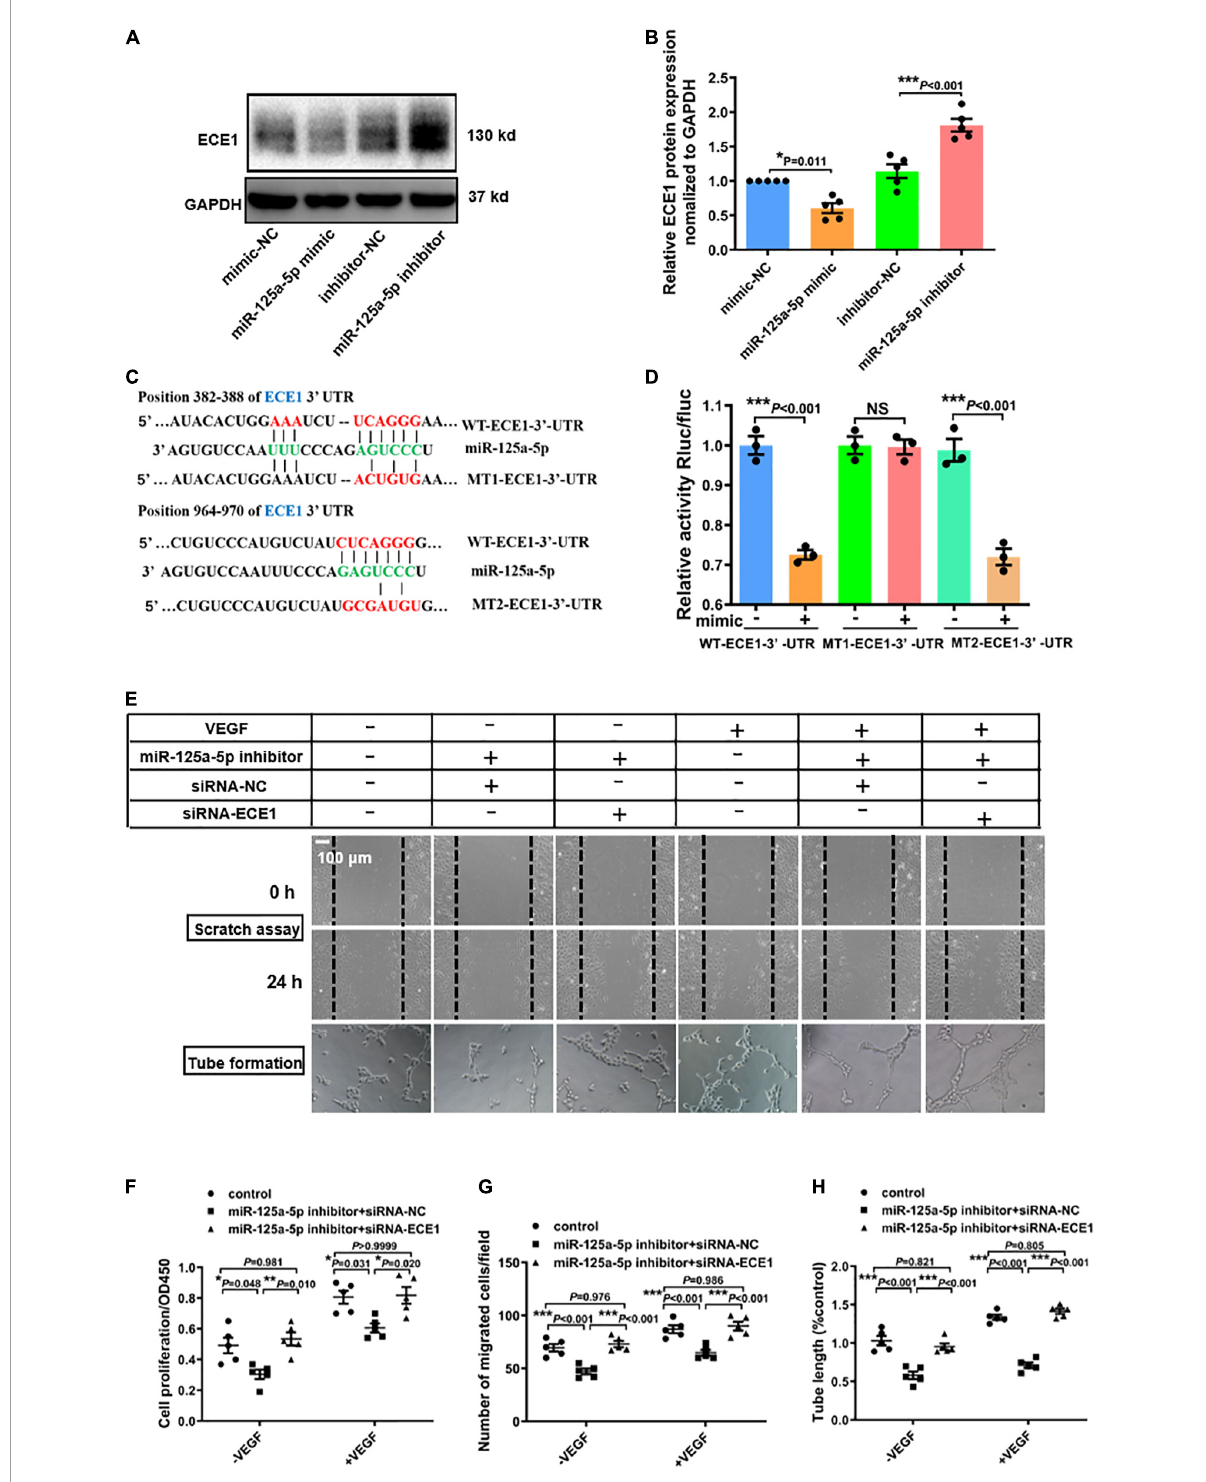
FIGURE5 miR-125a-5p promotes the proliferation, migration and tube formation of HUVECs by targeting ECE1. (A,B) HUVECs were transfected with miR-125a-5p mimic (50 nM) or miR-125a-5p inhibitor (100 nM) and the corresponding negative controls for 48 h. ECE1 protein was determined via western blotting. ** P < 0.01 vs. the corresponding negative control. (C) TargetScan prediction of miR-125a-5p targeting the 3 (cid:48) -UTR of ECE1 mRNA. (D) Plasmids for luciferase reporter construction containing the full-length wild-type 3 (cid:48) -UTR of ECE1 mRNA (WT-3 (cid:48) -UTR) and mutated 3 (cid:48) -UTR of ECE1 mRNA (MT1-3 (cid:48) -UTR and MT2-3 (cid:48) -UTR) were generated, and 293T cells were co-transfected with an miR-125a-5p mimic or